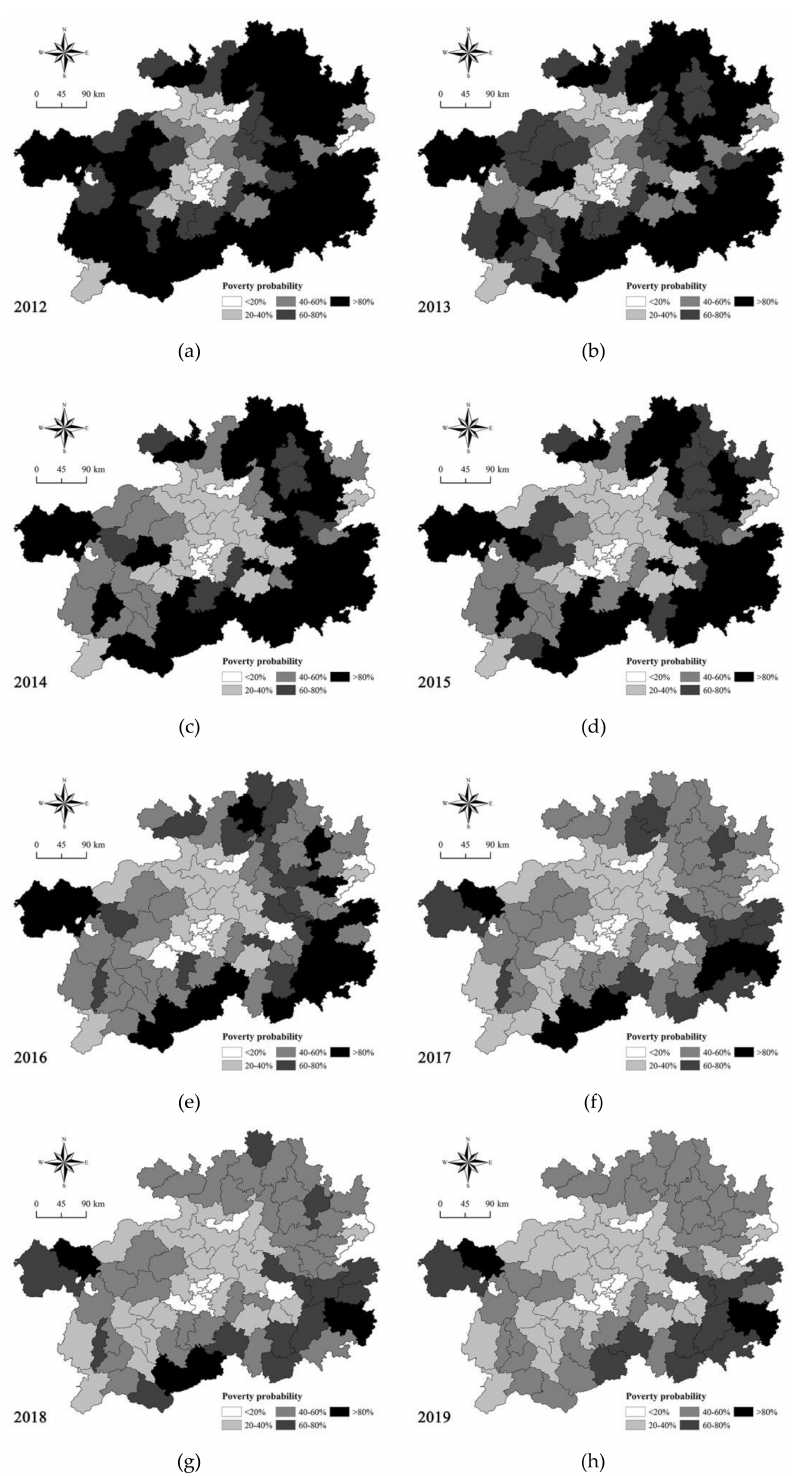
Figure 6. Distribution of poverty probability at the county level by RF from 2012 to 2019, (a) poverty probability at the county level by RF in 2012, ( b ) poverty probability at the county level by RF in 2013, ( c ) poverty probability at the county level by RF in 2014, ( d ) poverty probability at the county level by RF in 2015, ( e ) poverty probability at the county level by RF in 2016, ( f ) poverty probability at the county level by RF in 2017, ( g ) poverty probability at the county level by RF in 2018, ( h ) poverty probability at the county level by RF in